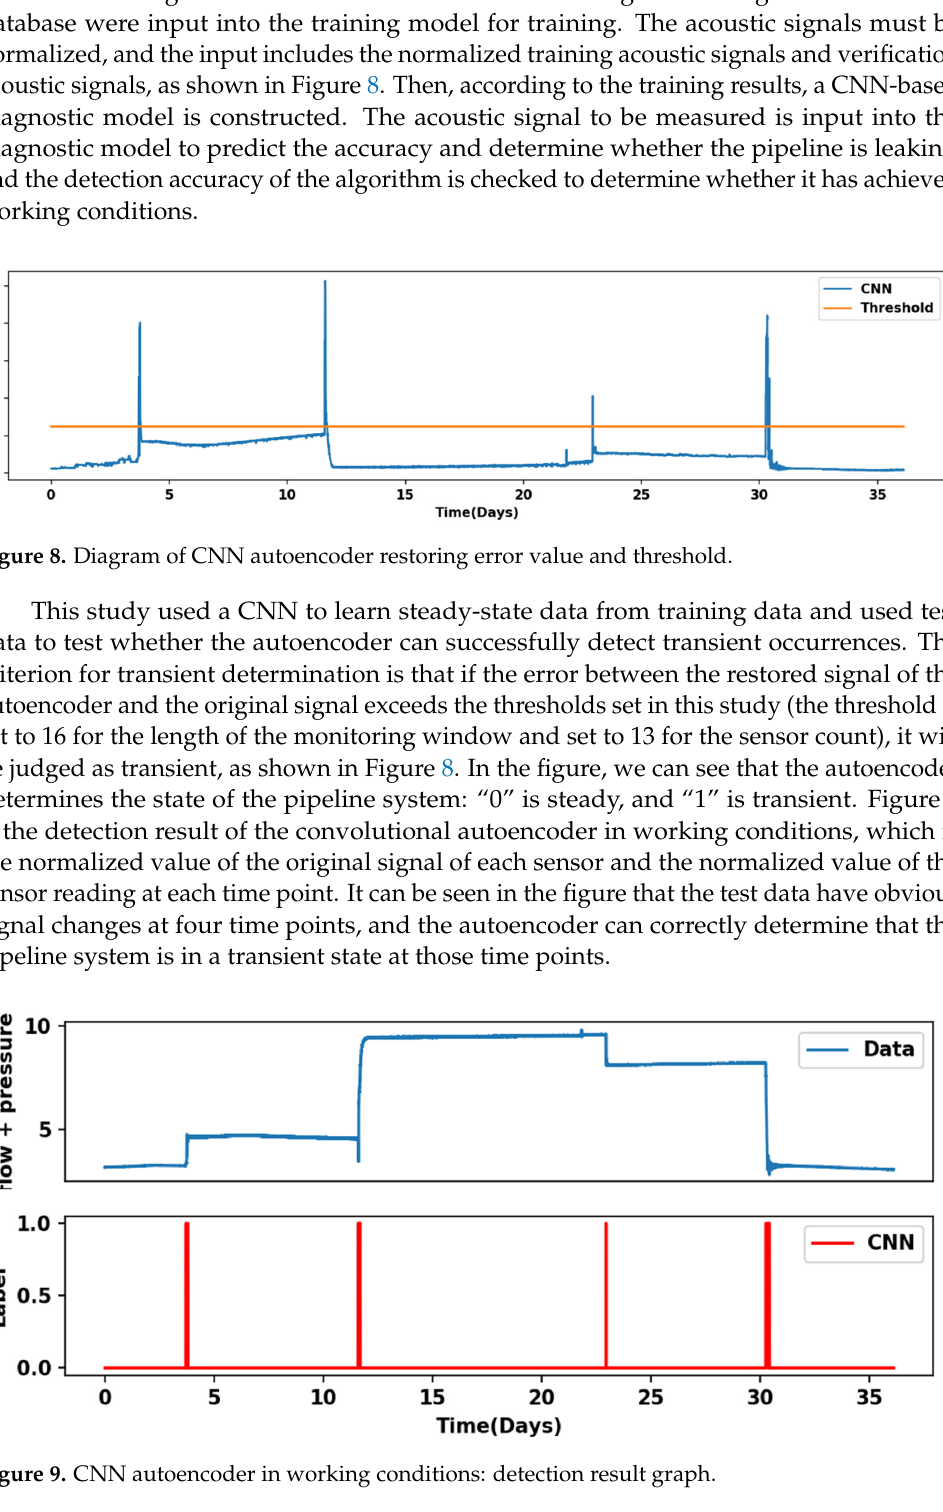
Figure 9. CNN autoencoder in working conditions: detection result